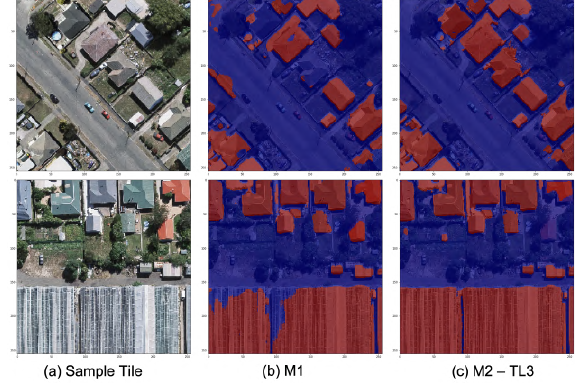
Figure 6 . Sample results from cross-validation of the base model (M1) of modified U-Net and fine-tuned model (M2) with three fine-tuning strategies (TL1, TL2, and TL3) on the WHU Building dataset